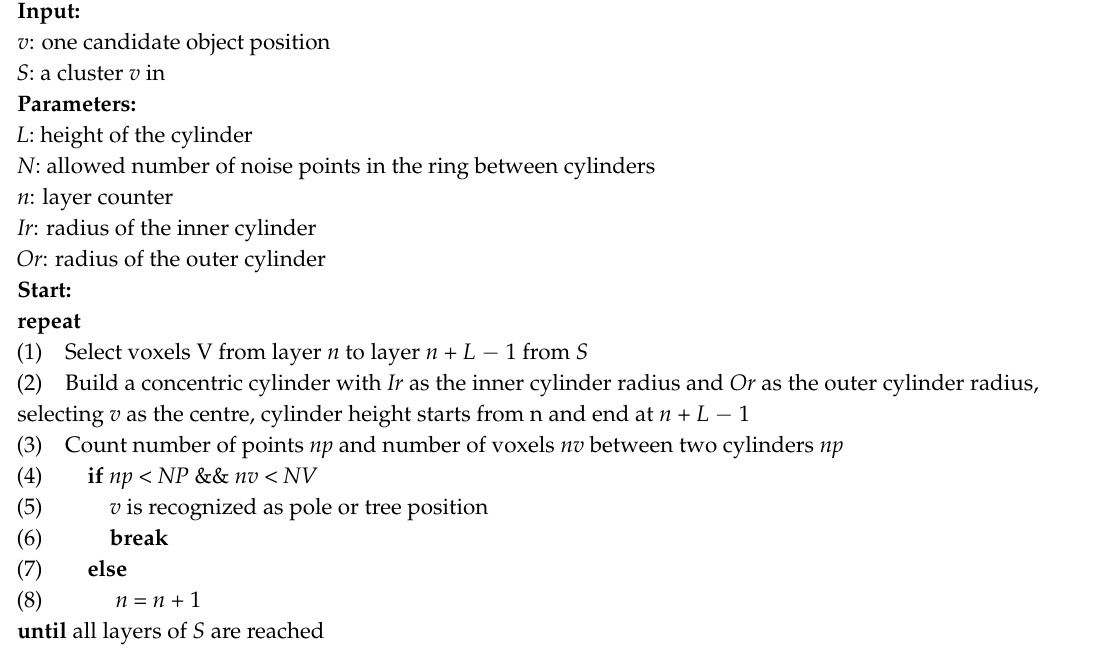
Algorithm 1 Isolation analysis for